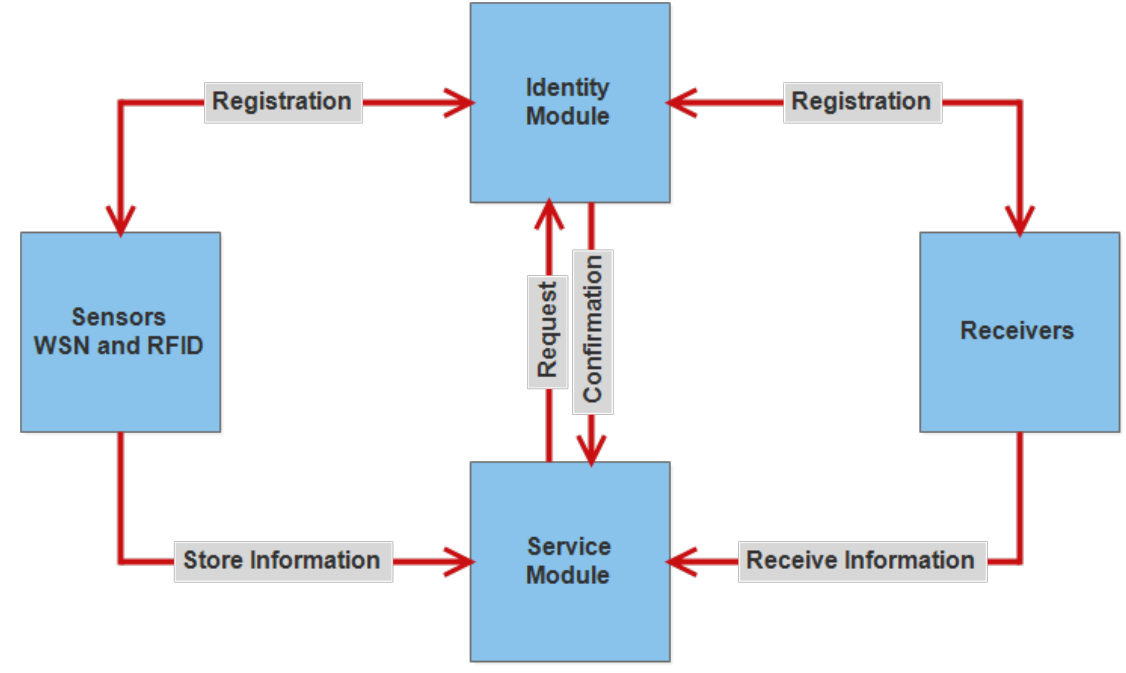
Figure 13. Identity management framework for cloud based IoT